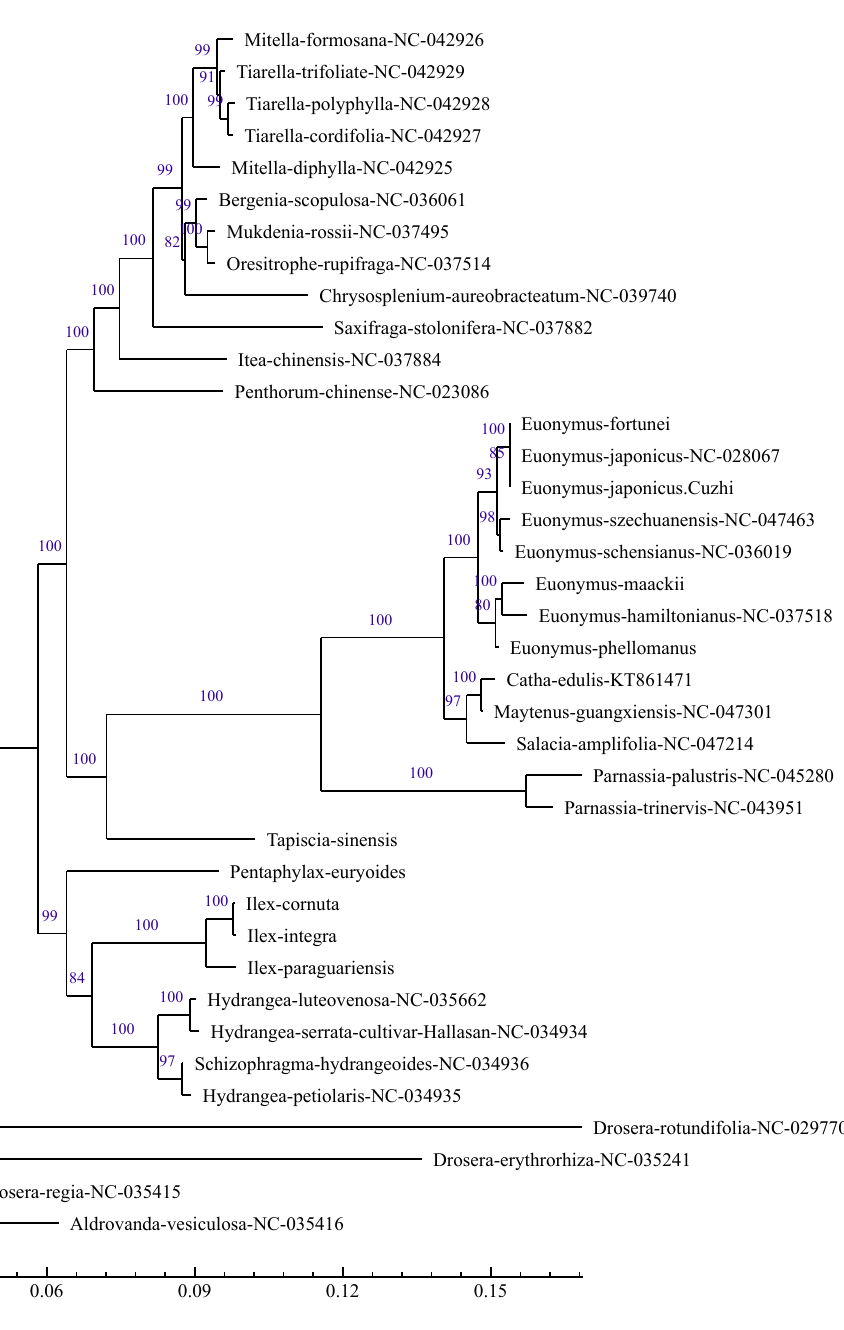
Figure 10. Phylogenetic tree based on complete chloroplast genome sequences from 38 species. The numbers on the branches represent reliability, and the maximum is